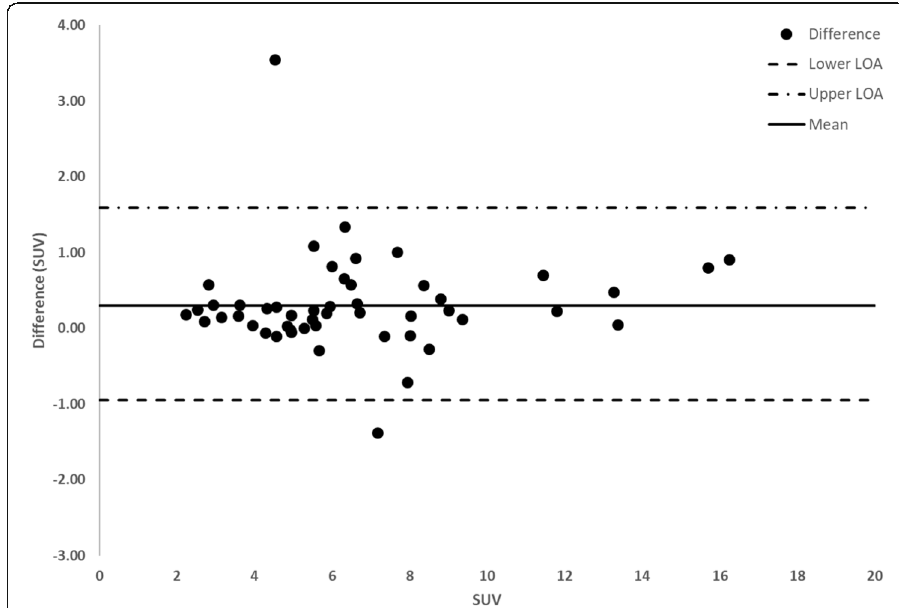
Fig. 4 Bland-Altman plot demonstrating differences in SUV as a function of average SUV between step- and-shoot (SS) and simulated step-and-shoot continuous (SimSSC) mode, pooling 50 lesions from 10 patients (5 lesions per